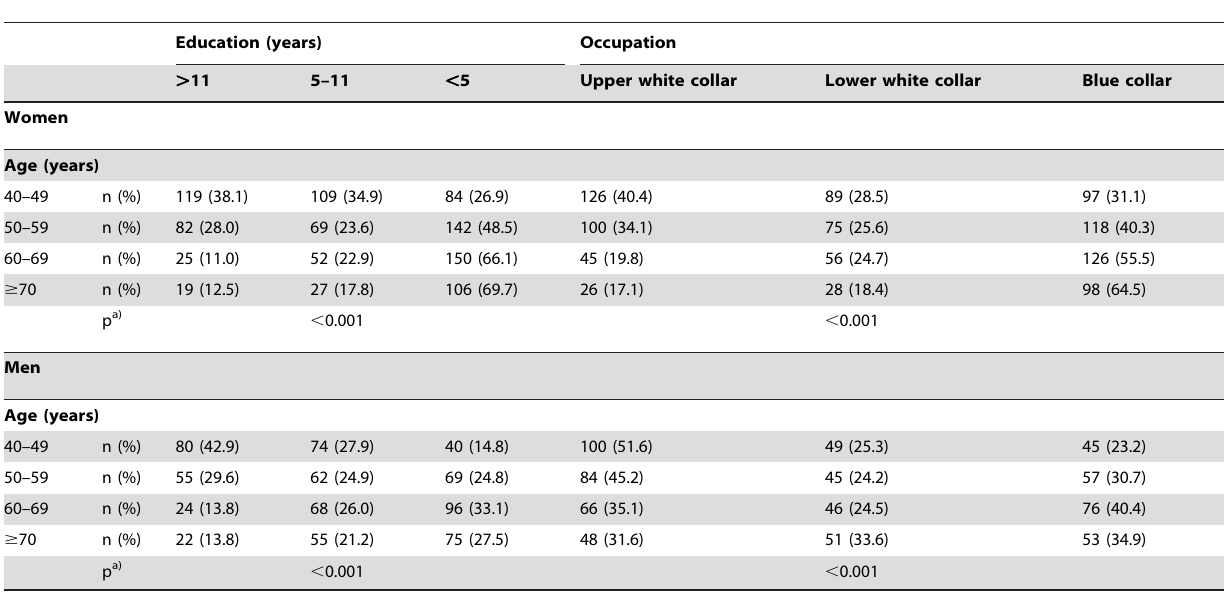
Table 1. Distribution of educational and occupational classes by age